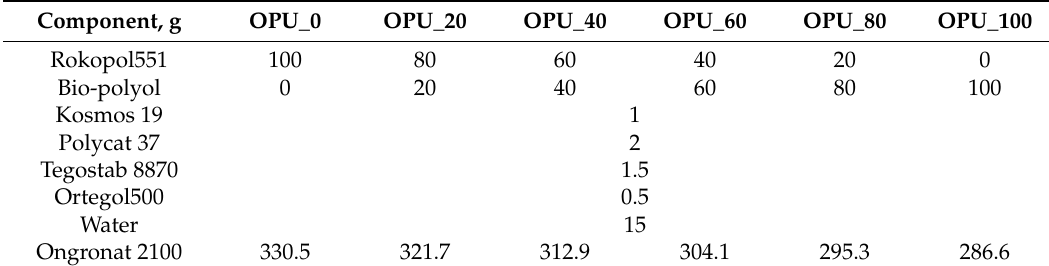
Table 1. Formulations of